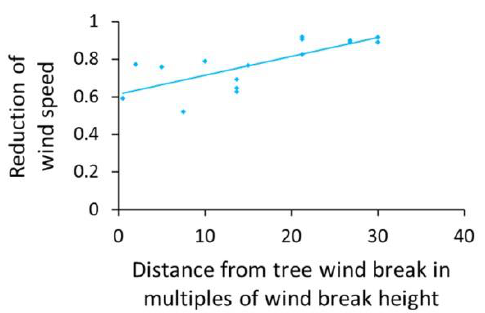
Figure 8. Reduction of wind speed along increasing distance from the single row tree wind break. The reduction of wind speed is given as multiples of open field wind speed.